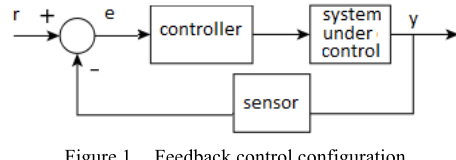
Figure 1. Feedback control